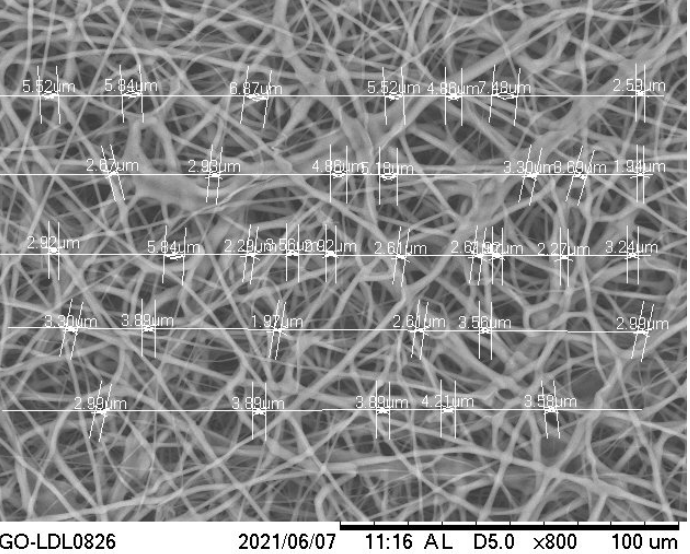
Figure 2. Method of pore size measurements using line intercept method from a Scanning Electron Microscope (SEM) image using ImageJ software.